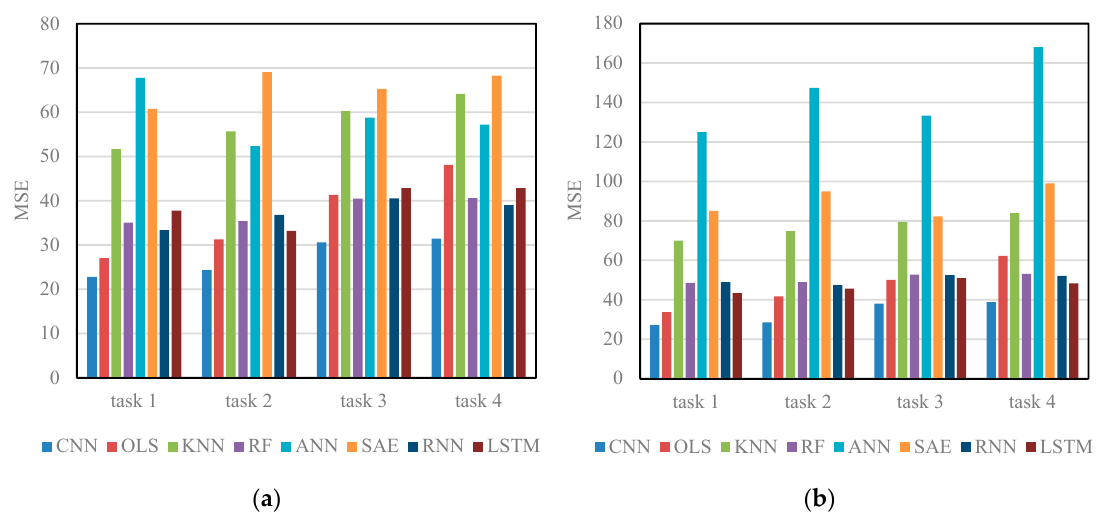
Figure 6. Results of different algorithms: ( a ) MSEs on Network 1; and ( b ) MSEs on Network 2.